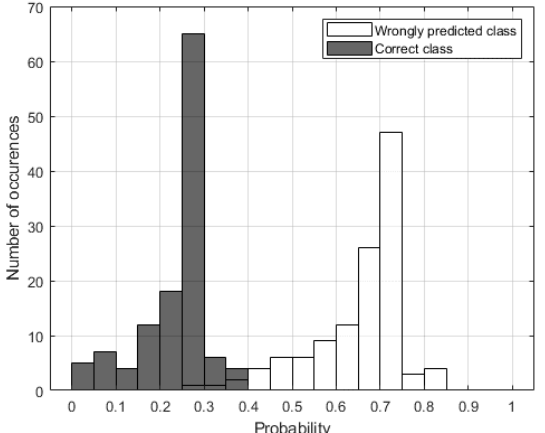
Figure 9. Histogram for estimated probability for the incorrectly classified events using the linear SVM classifier with feature selection.